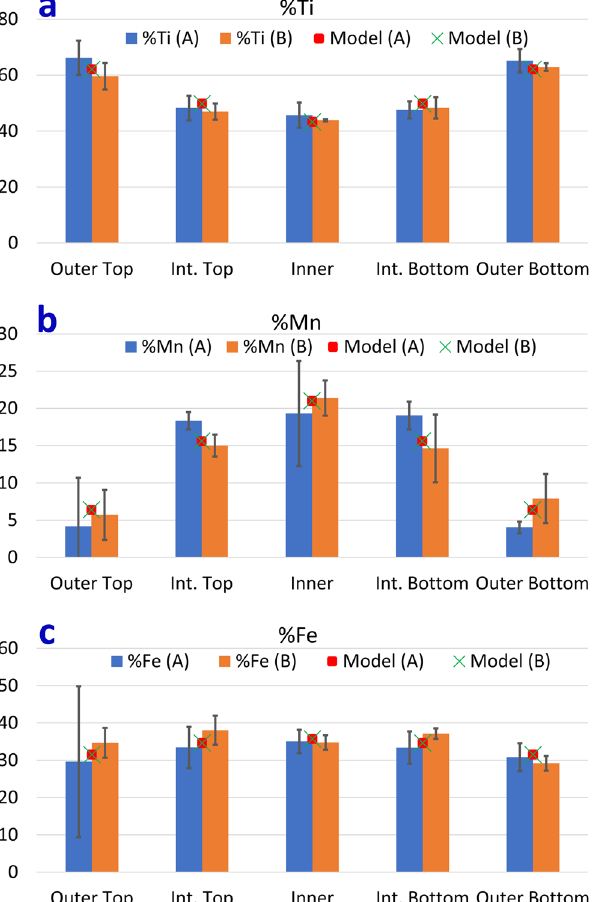
Figure 3. The relative B-site proportions (in %) of Ti, Mn and Fe were quantified by taking horizontal line profiles of the EDX data across the B-sites of the PK layers over three half-unit cells analysed and the averages for the outer top (O-top), intermediate top (M-top), centre (C), intermediate bottom (M-bottom) and outer bottom (O-bottom) PK layers. These are represented in the histograms shown in ( a to c ), respectively. Note that the data presented is for regions without OPBs/stacking faults. The error bars represent the spread in measured compositions for three PK layers. The experimental values of C(x) (Supplementary Table S1) have been fitted using Equations (1) and (2) and the modelled values are plotted for both B6TFMO-A and B6TFMO-B as represented by the Model (A) red square and the Model (B) green